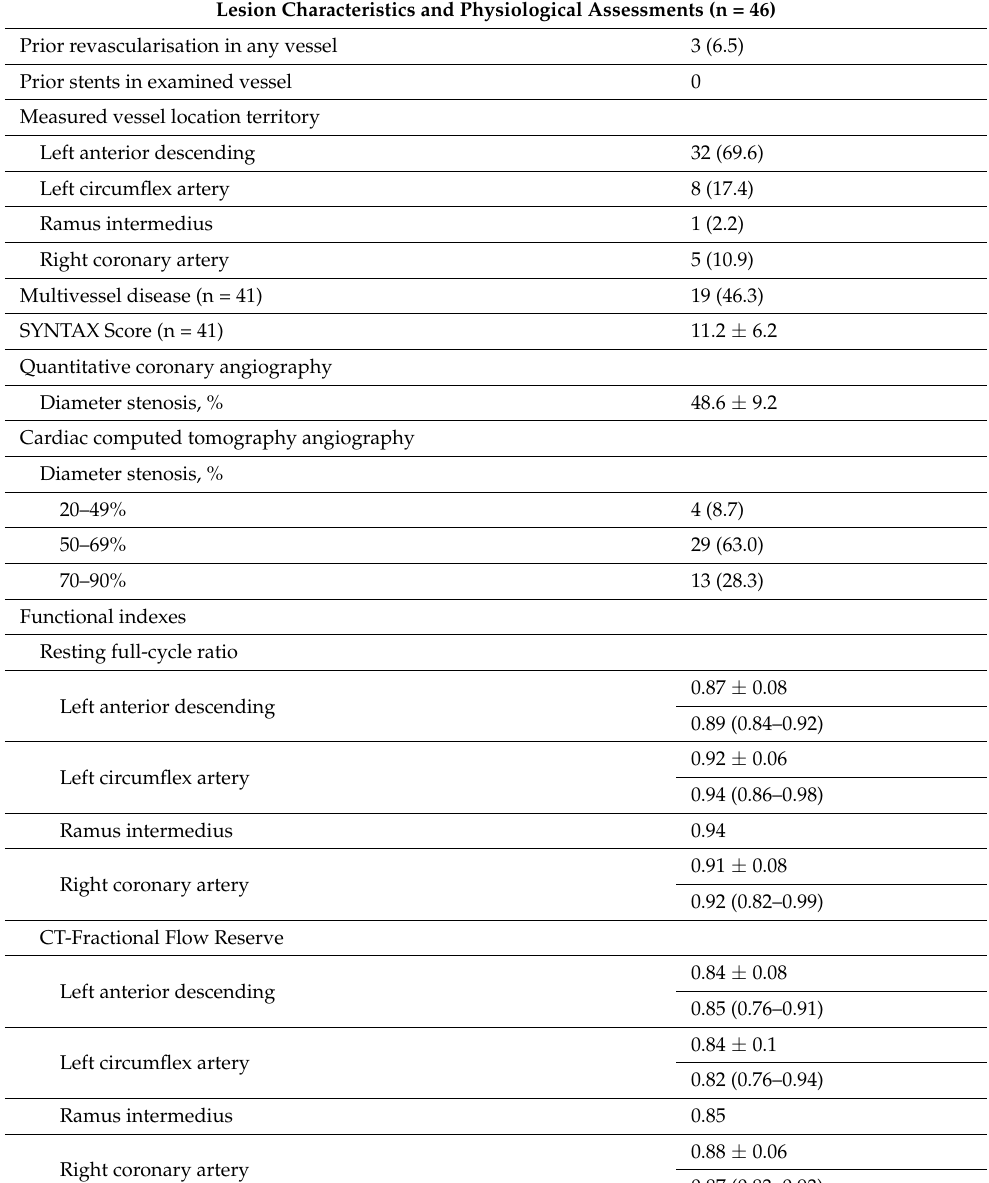
Table 2. Lesion characteristics and physiological assessments (n =